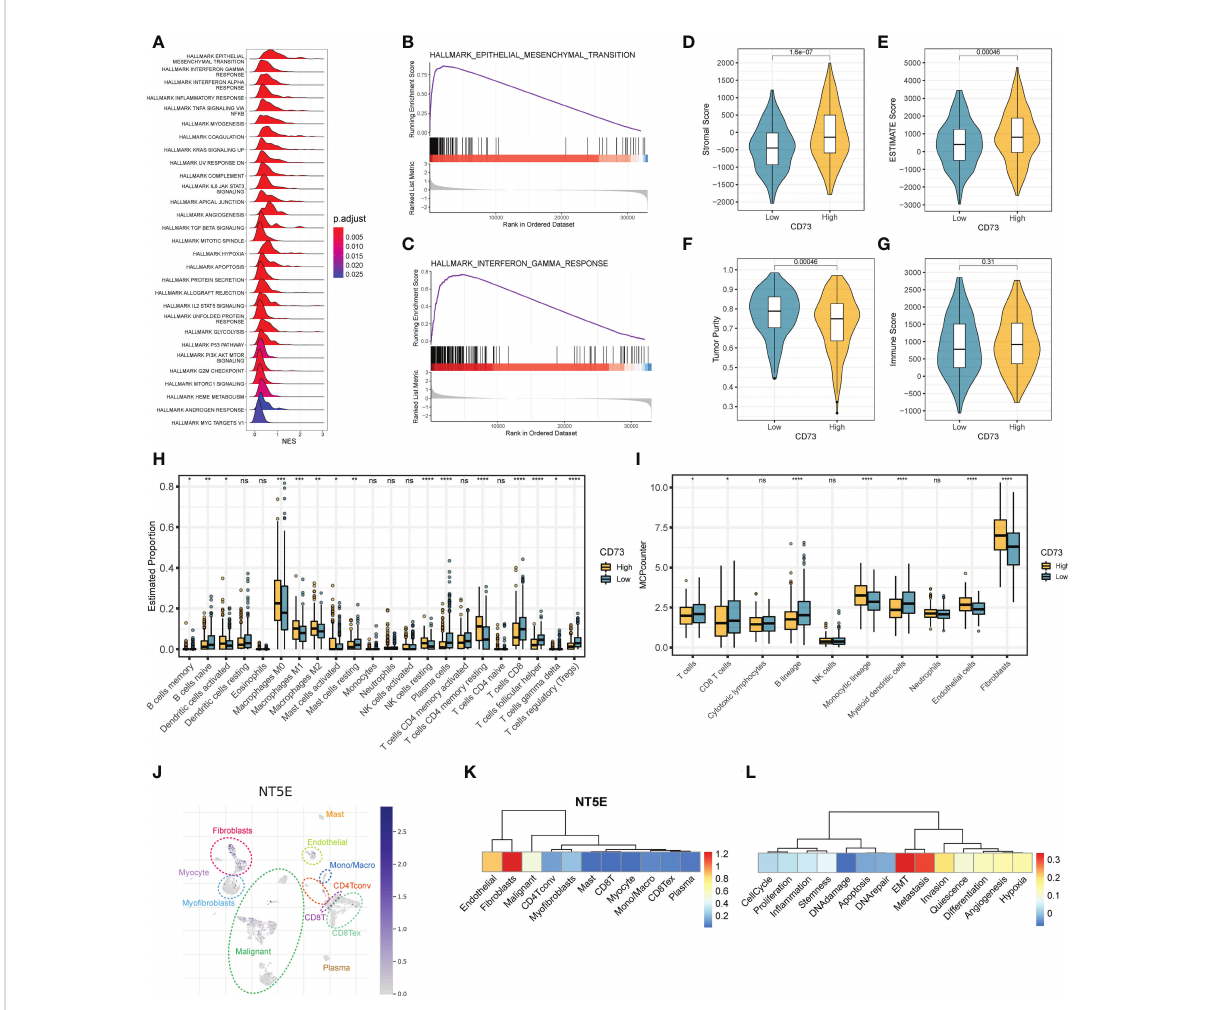
FIGURE 2 The regulatory mechanisms and immunosuppressive function of CD73 in HNSCC. (A) The enrichment score of HALLMAKR pathways in fl uenced by CD73. NES, normalized enrichment score. (B) Visualization of top 1 pathway. (C) Visualization of the second pathway. (D) Comparison of stromal score calculated by ESTIMATE algorithm. (E) Comparison of ESTIMATE score calculated by ESTIMATE algorithm. (F) Comparison of tumor purity calculated by ESTIMATE algorithm. (G) Comparison of immune score calculated by ESTIMATE algorithm. (H) Comparison of proportions of 22 immune cell types estimated by CIBERSORT algorithm. (I) Comparison of proportions of different kinds of cells estimated by MCP-counter algorithm. (J) The expression pattern of CD73 in tumor microenvironment at single-cell revolution, cells were clustered and annotated through TISCH database. (K) The expression of CD73 in these cells. The redder the color, the more CD73 is expressed in these cells. (L) Correlations between CD73 expression and various tumor signatures. *p < 0.05; **p < 0.01; ***p < 0.001; ****p < 0.0001; ns, no signi fi